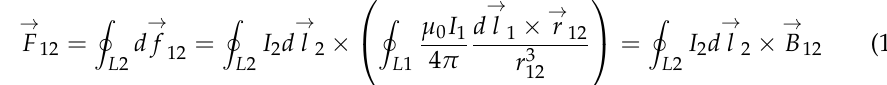
According to Newton’s Third Law of Motion, the electromagnetic force on coil 1 is shown in Equation (13) below. Since the system is not acted by external force and torque, the angular momentum between the coils is conserved, as shown in Equation (14).